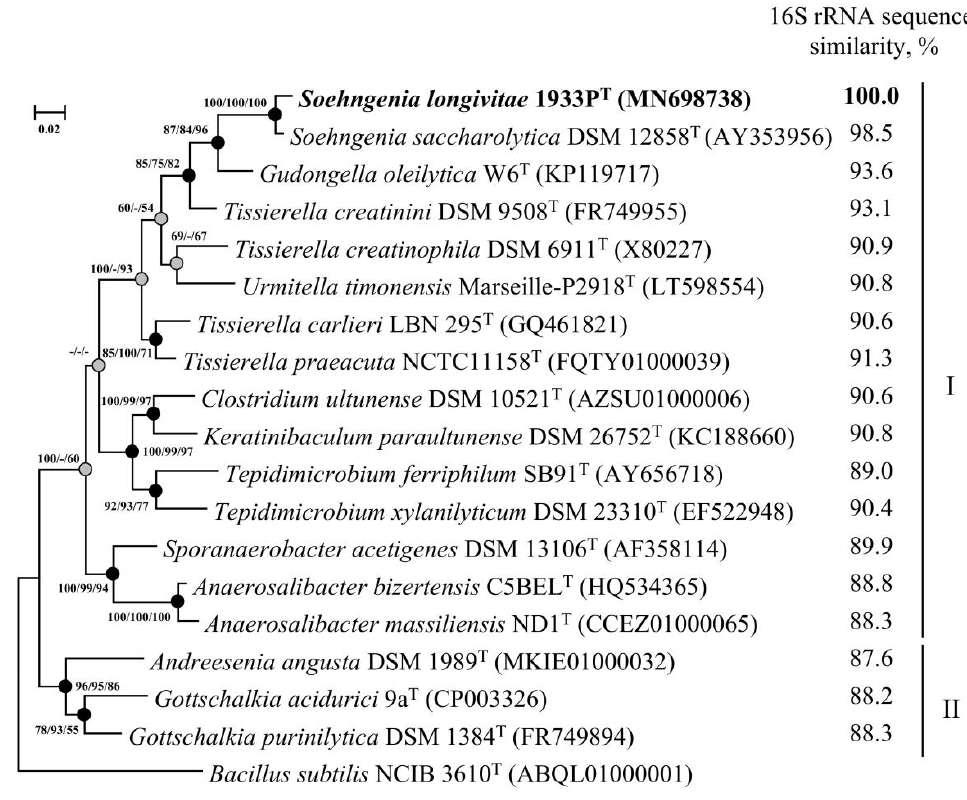
Figure 2. Maximum-likelihood phylogenetic tree based on 16S rRNA gene sequences (1498 nucleotide sites) reconstructed with the evolutionary model GTR + F + I + G4, showing the position of strain 1933P T and closely related members of the families Tissierellaceae (I) and Gottschalkiaceae (II). Grey circles indicate that the corresponding nodes were recovered in the tree that was reconstructed based on the maximum parsimony algorithm; black circles indicate that the corresponding nodes were also recovered based on the neighbour-joining and maximum-parsimony algorithms. Bootstrap values (>50%) are listed as percentages at the branching points. Scale bar, 0.02 substitutions per nucleotide position. The 16S rRNA gene sequence similarity refers to strain 1933P T compared to the rest of the species. The tree was rooted using Bacillus subtilis NCIB 3610 T as the outgroup. GenBank accession numbers for 16S rRNA genes are indicated in brackets.